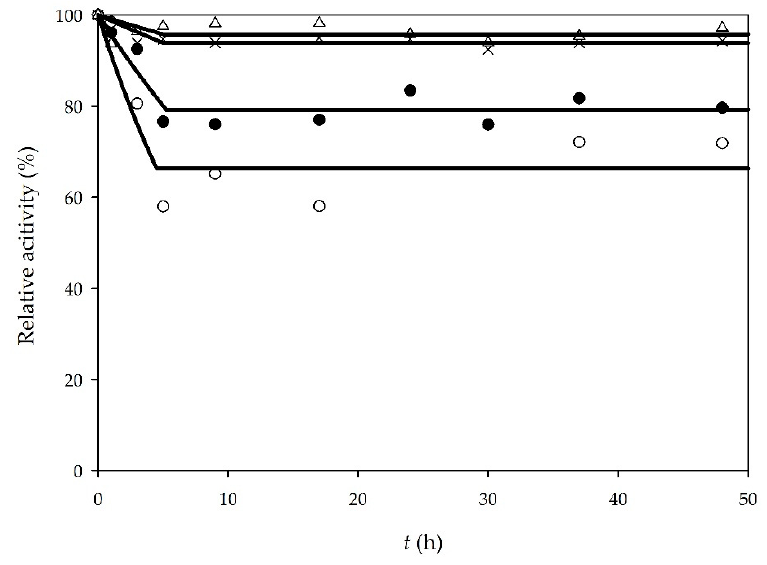
Figure 1. Lipase stability in batch processes ( ○ —edible oil, enzyme dissolved in buffer, ● —waste oil, enzyme dissolved in buffer, ∆ —edible oil, enzyme dissolved in deep eutectic solvent (DES), ×—waste oil, enzyme dissolved in DES).